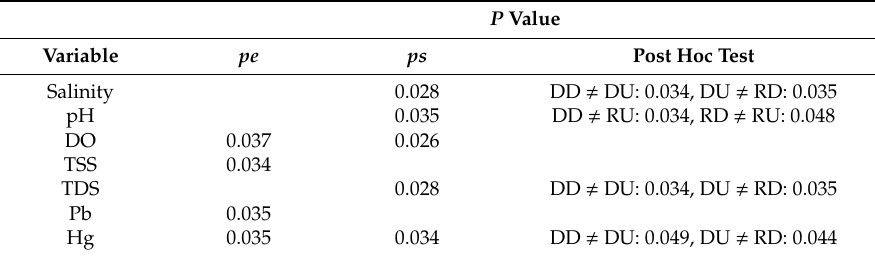
Table 1. The significant p values generated from ANVOVA / permutational PERMANOVA and post hoc comparison analyses for environmental variables ( pe: the significant estuary e ff ects, ps: estuarine-section e ff ect. “ (cid:44) ” sign indicated for the significant di ff